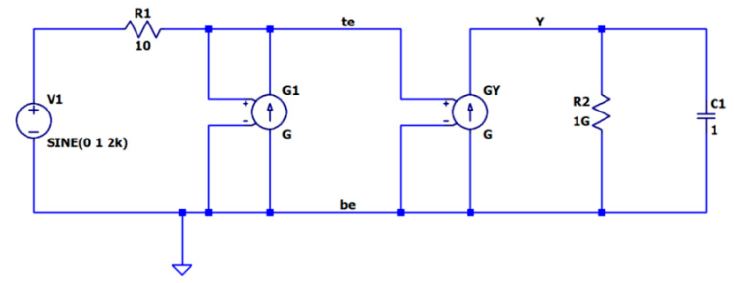
Figure 6. Generalized LTSpice schematic of a memristor model.